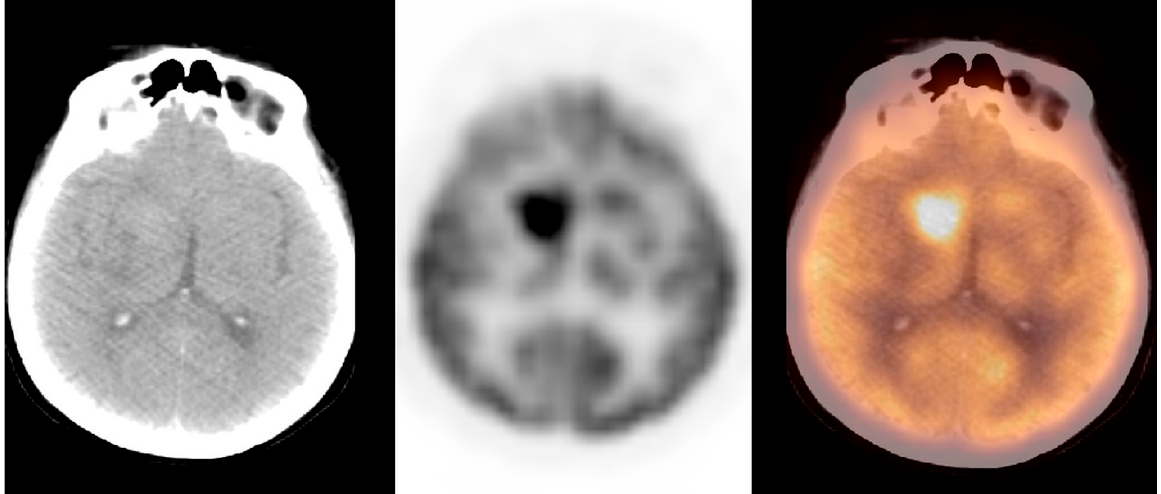
Figure 5. A hyperdense and hypermetabolic mass in the right thalamus region, consistent with primary brain tumour (glioblastoma), in a patient with breast cancer (source: original figure). Description: axial view of the brain and torso [ 18 F]FDG PET/CT over the middle cranial fossa—low-dose CT ( left -hand side image), PET ( middle image), and PET/CT fusion ( right -hand side image).